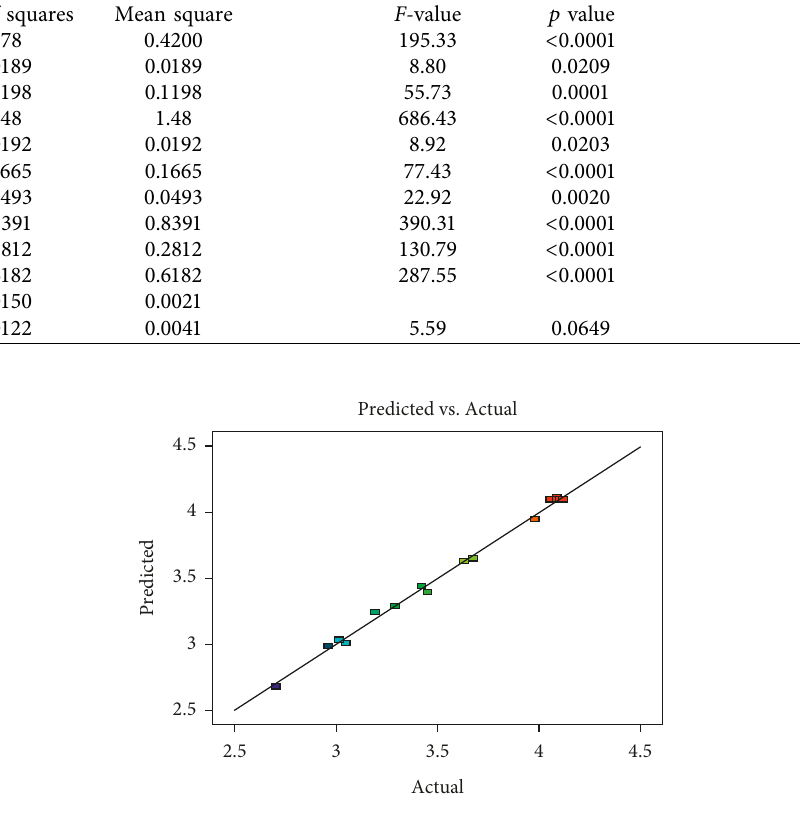
Figure 1: Diagnostic plot of model adequacy (predicated vs.